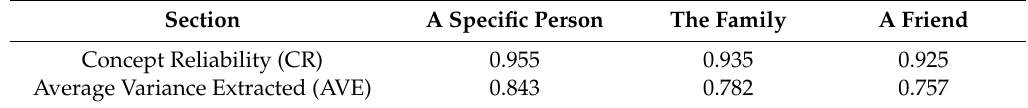
Table 4. Average variance extracted (AVE) and concept reliability (CR) for social support.